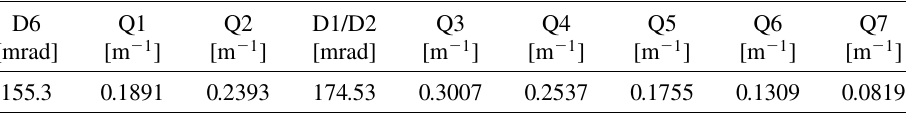
TABLE IV. The strength of the magnetic elements corresponding to the first-order beam optics of the NSRL line used to generate uniform beam at the target when the octupoles are